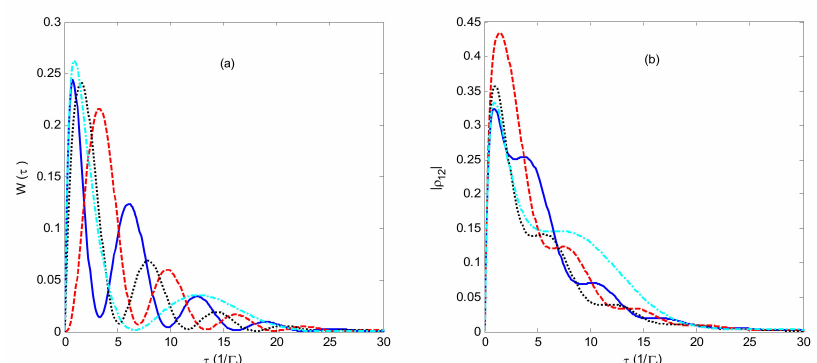
(cid:12) (cid:12) (cid:12) (cid:12) (cid:12) as a function of time τ . The blue solid line is (cid:12) ρ 12 η = 1, Γ α = = Γ = 0.4 Γ 0 , δε 0 ); l